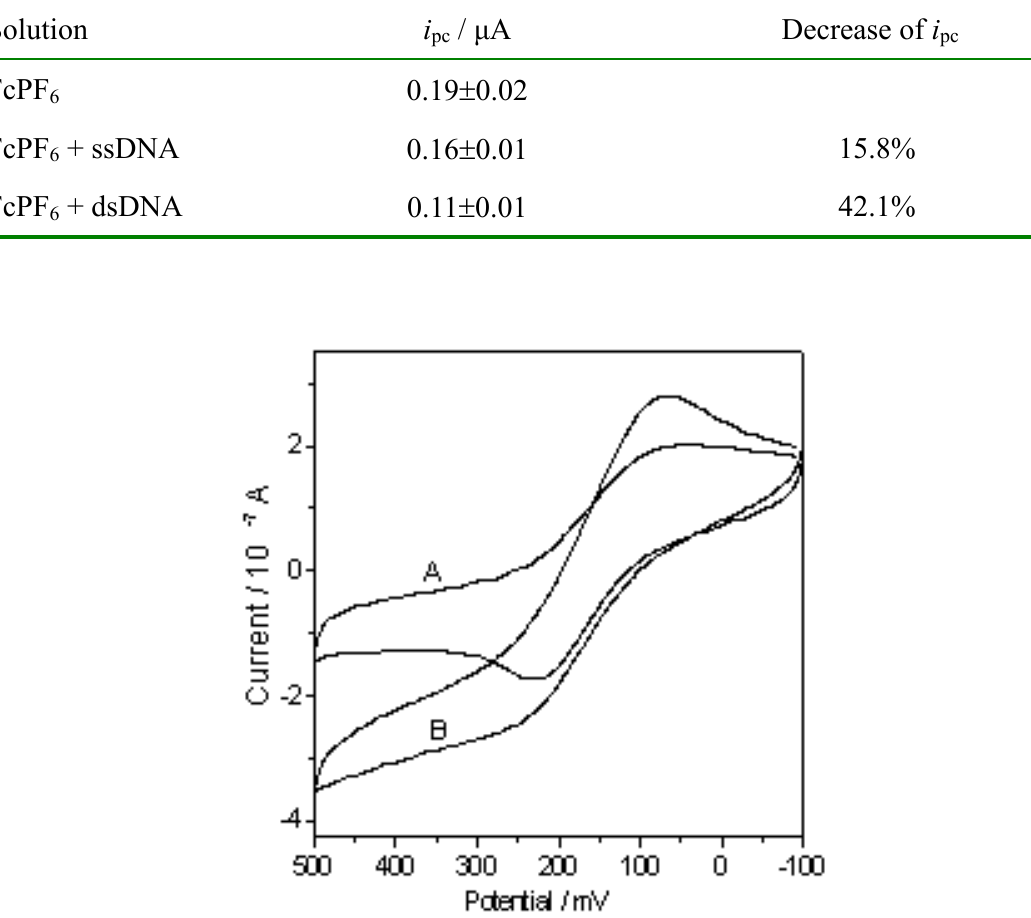
Table 1. Cathodic peak current of 0.4 mM FcPF 0.5 mg ml -1 ssDNA or dsDNA.